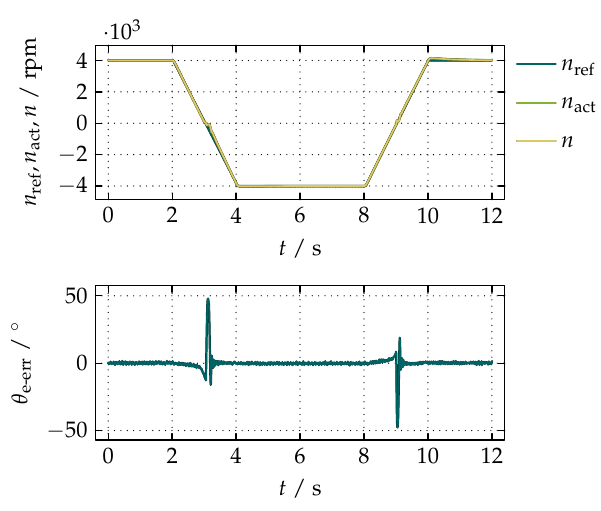
Figure 17. A reversal of the unloaded motor from 4000 rpm to 4000 rpm and back. − A small difference between n act and n is noticeable only around zero when the distortion in the waveforms of the voltage and the current caused by a limited resolution of the measurement sensors and quantization errors increase the uncertainty of knowing the actual angular position of the rotor. The positive peak of θ e-err is + 47.95 ◦ , which within 0.31 s falls below 10% of its value, while the negative peak of 47.61 ◦ becomes smaller than 10% of its absolute value within 0.21 s. The dynamics − of the proposed compensation is demonstrated in Figure 18 by applying the step in the speed from 100 rpm to 4000 rpm to the unloaded motor.